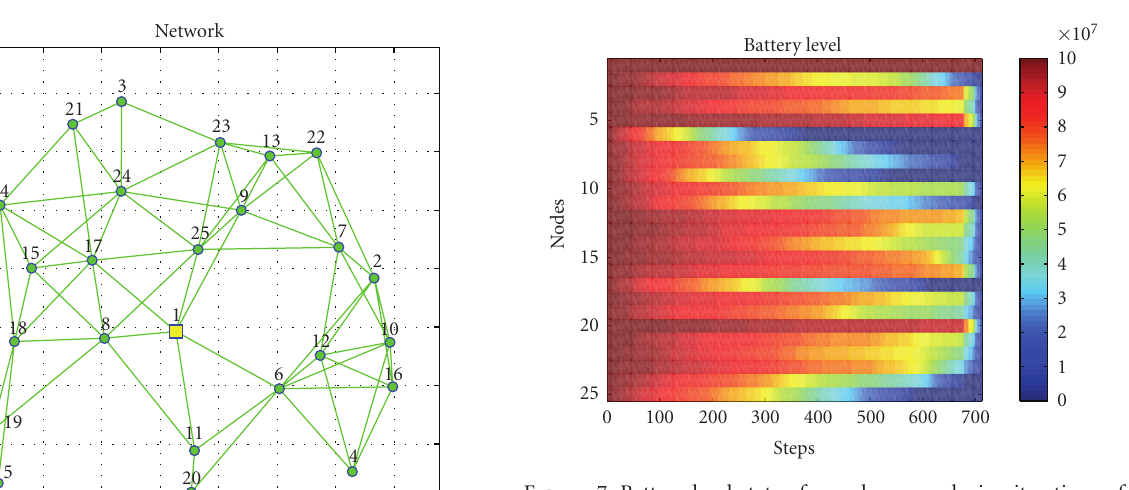
of the connectivity of the network. For each sender of the sequence, the GSO performs N i = 100 iterations in search of the best possible path accordingly with the adopted criteria.